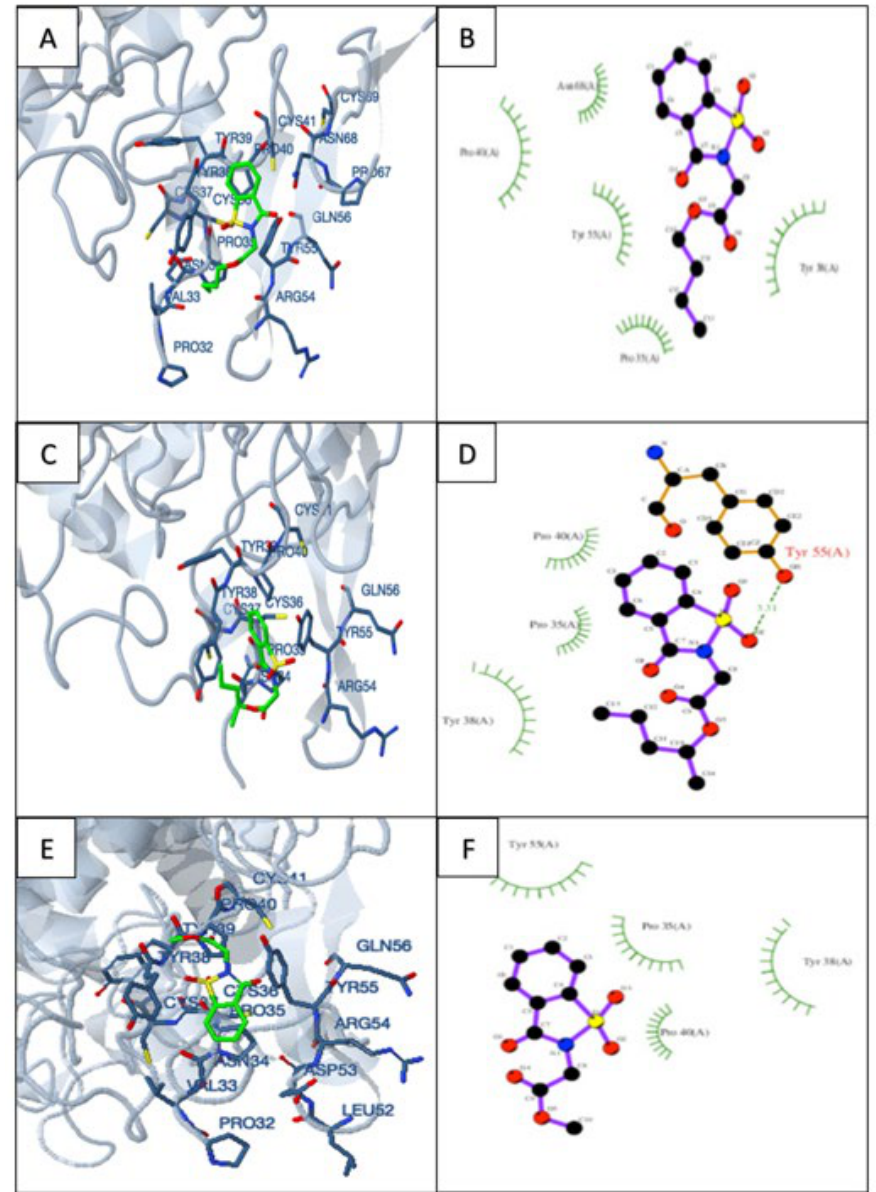
Figure 3. ( A , B ) Molecular docking studies 3D, and 2D representations for ester 3d . ( C , D ) 3D, and 2D representations for ester 3g . ( E , F ) 3D, and 2D representations for ester 3a . Hydrogen bonds highlighted in green with the respective distances between the atoms involved, whereas polar, hydrophobic, and other bonds are represented by an arc with spokes radiating towards the ligand atom.